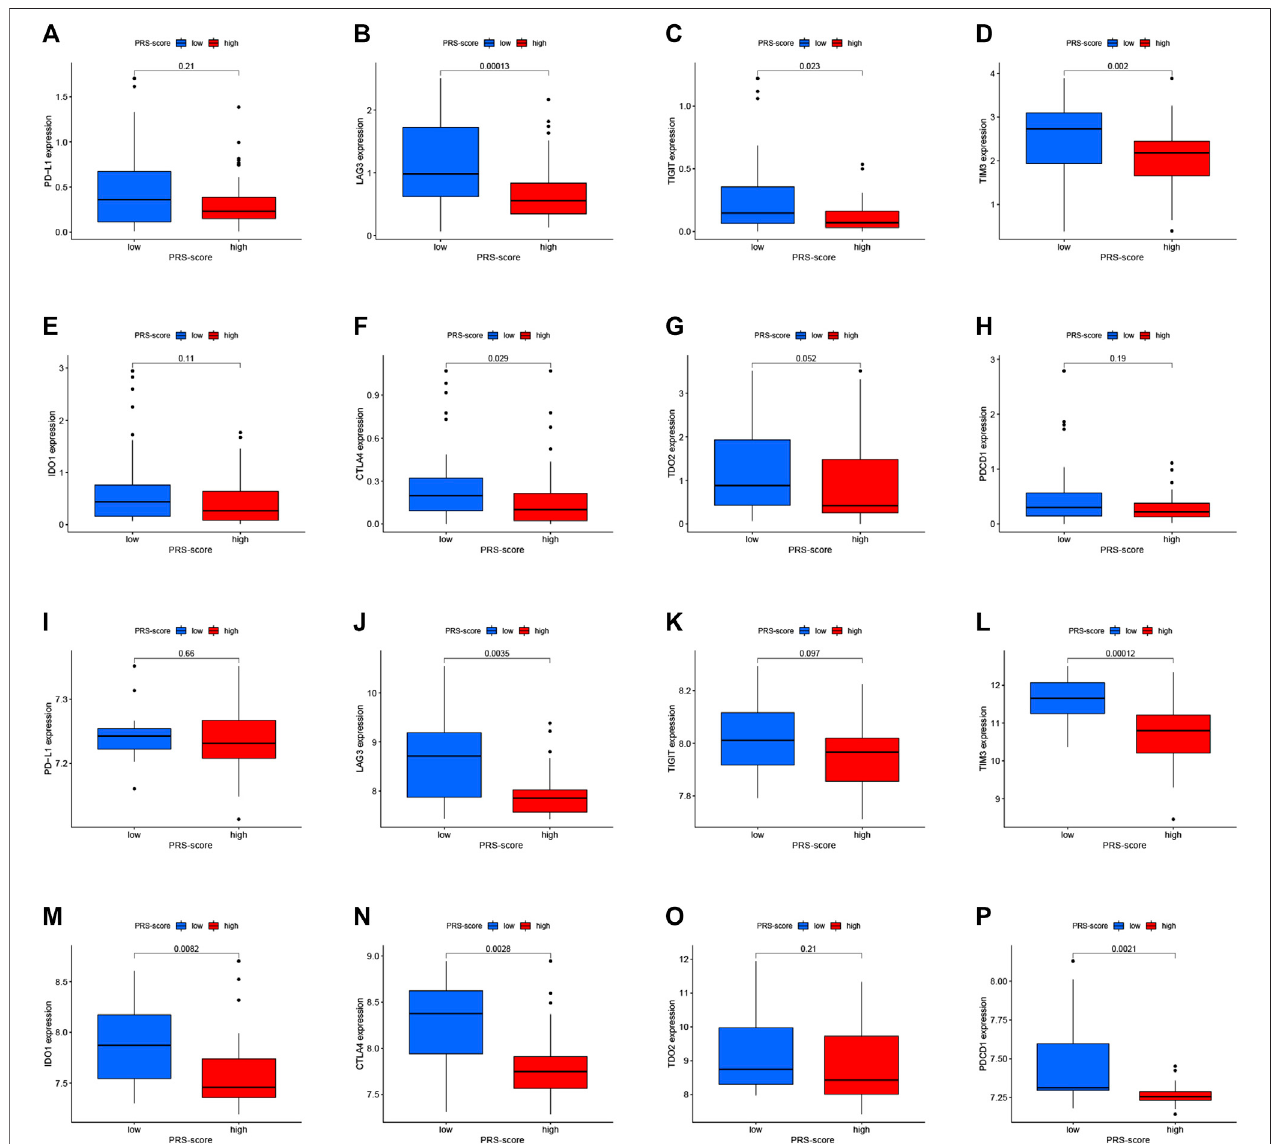
FIGURE 9 | Immune checkpoint molecules expression analysis. (A – H) The expression levels of Immune checkpoint molecules, including PD-L1 (A) , LAG-3 (B) , TIGIT (C) , TIM-3 (D) , IDO1 (E) , CTLA-4 (F) , TDO2 (G) , and PDCD1 (H) between high and low PRS-score groups in the TARGET cohort. ( I – P ) The expression levels of Immunecheckpointmolecules,includingPD-L1 (I) ,LAG-3 (J) ,TIGIT (K) ,TIM-3 (L) ,IDO1 (M) ,CTLA-4 (N) ,TDO2 (O) ,andPDCD1 (P) betweenhighandlowPRS-score groups in the GEO